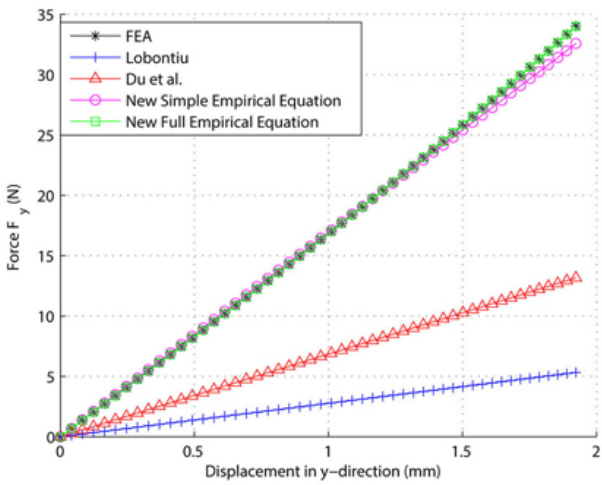
Figure 16. Comparison between FEA results and sti ff ness equa- tions results t / l = 0 . 5.